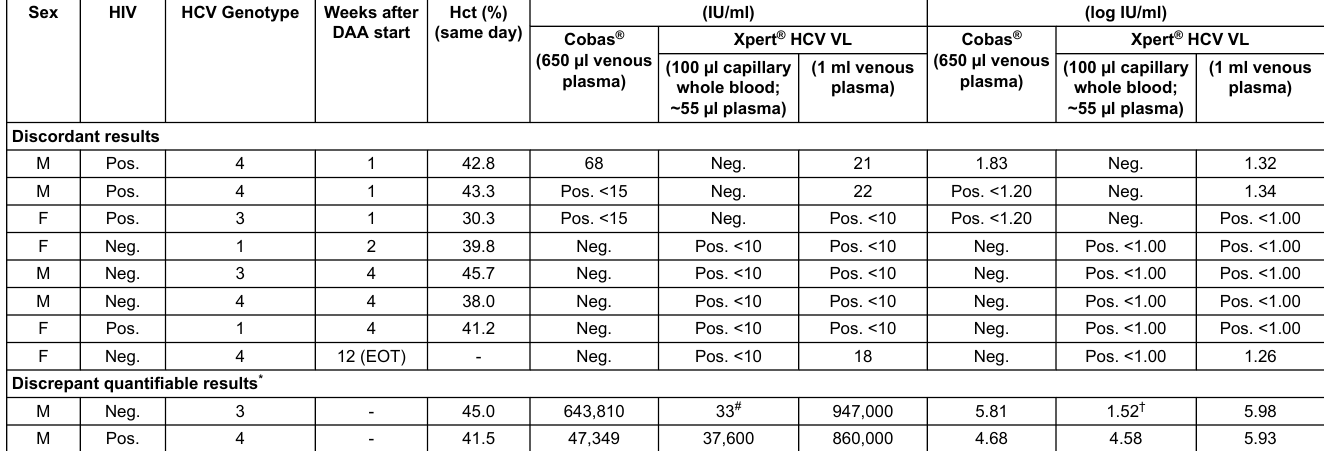
Table 4: Xpert ® HCV Viral Load (VL) test: characteristics of the eight discordant and the two discrepant quantifiable results. Sex